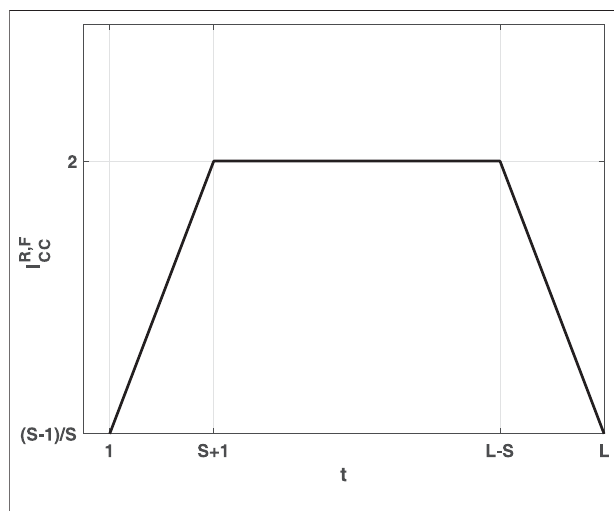
FIGURE 3 | The distribution of concave indicators I R , F CC in an ideal concave trajectory of length L with time scope S .